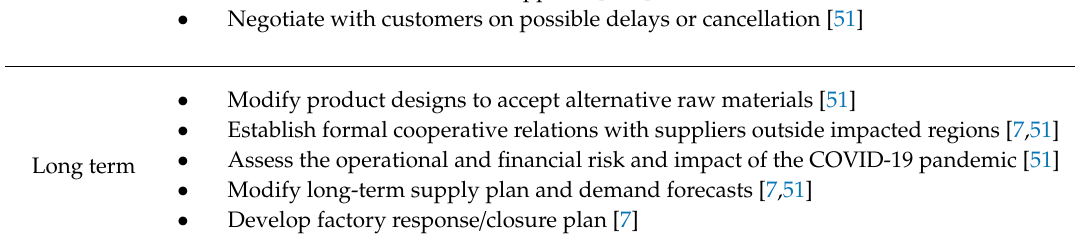
Figure 2. Four types of factory shutdowns amid the COVID-19 pandemic (red parts indicating the causes of shutdowns).